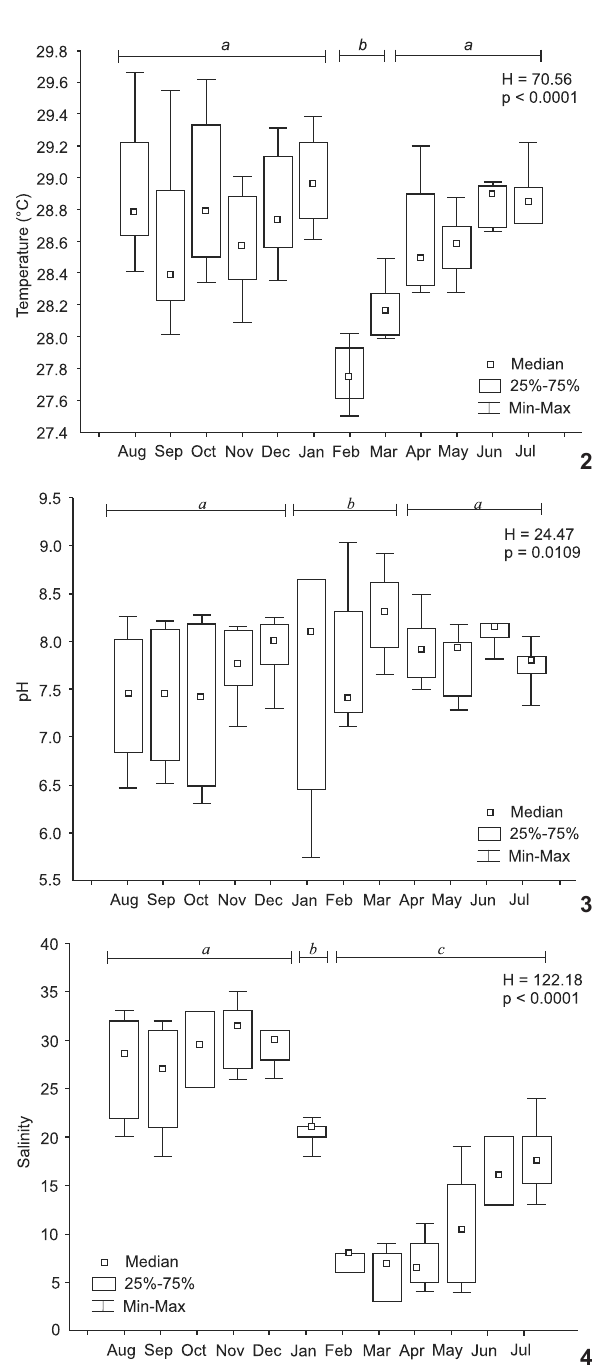
Figures 2-4. Monthly variation in the abiotic factors of the Marapanim Estuary, Brazil, between August 2006 and July 2007. (2) Temperature; (3) pH (shallow waters); (4) salinity (shallow waters). Distinct letters represent significant differences between months ( (cid:2) = 0.05).